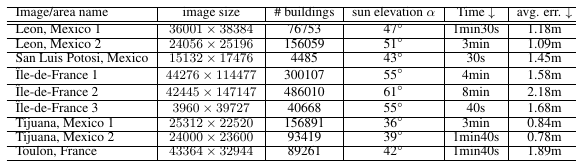
Table 1. Test results for the building height estimation step on satellite images with a GSD of 50cm. Times only include the height estimation itself (excluding building extraction) on an Intel i9-10850K CPU Figure 12. Left: building extraction from (Tripodi et al., 2019), right: our building extraction. Both use our polygonisation technique.